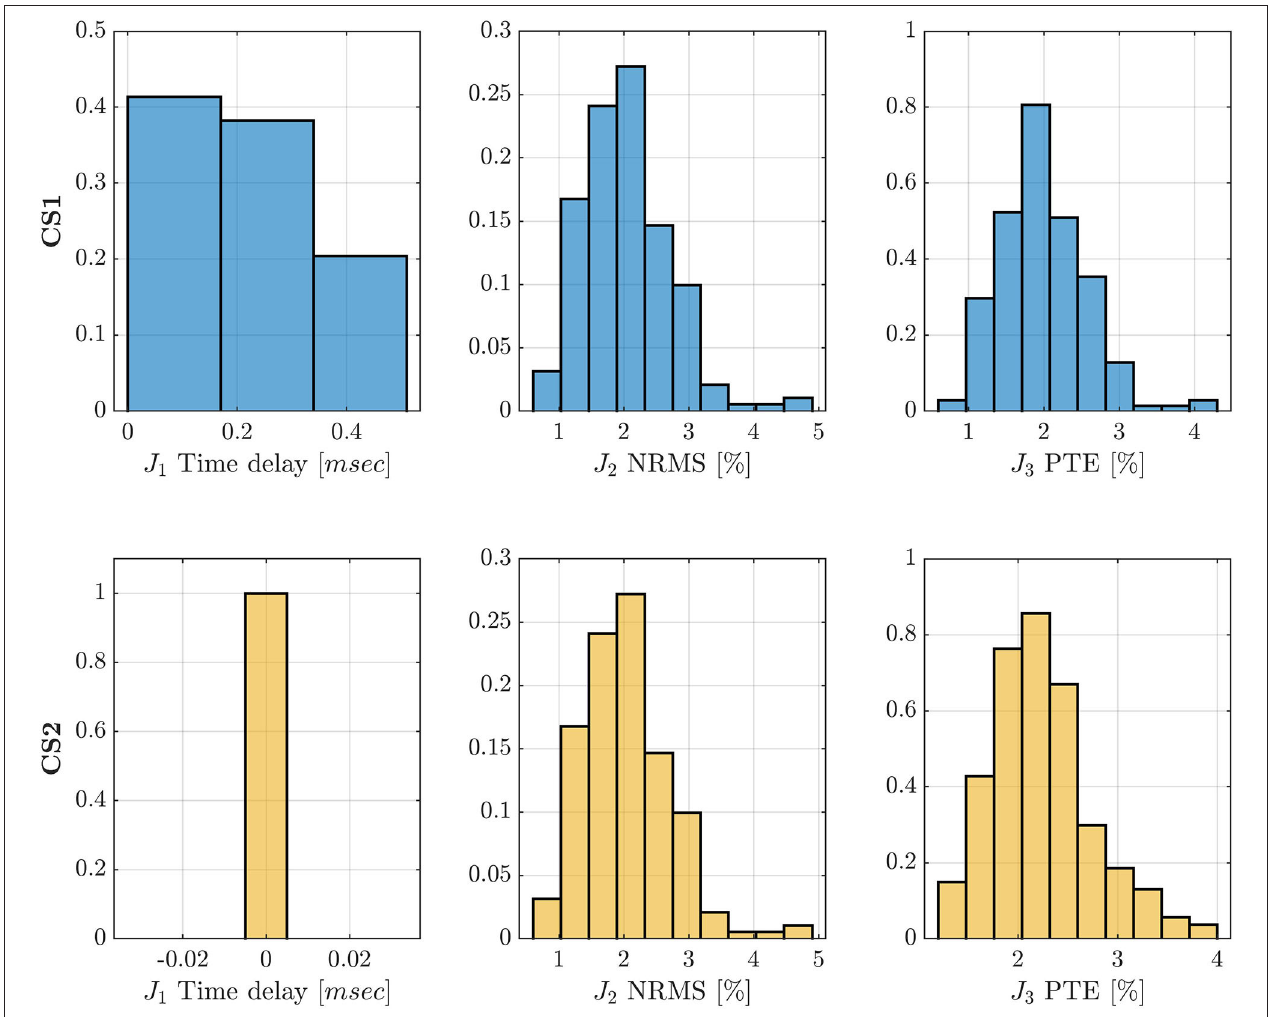
FIGURE 7 | Normalized histograms of J 1 , J 2 , and J 3 for CS1 and CS2, obtained from 200 vRTHS